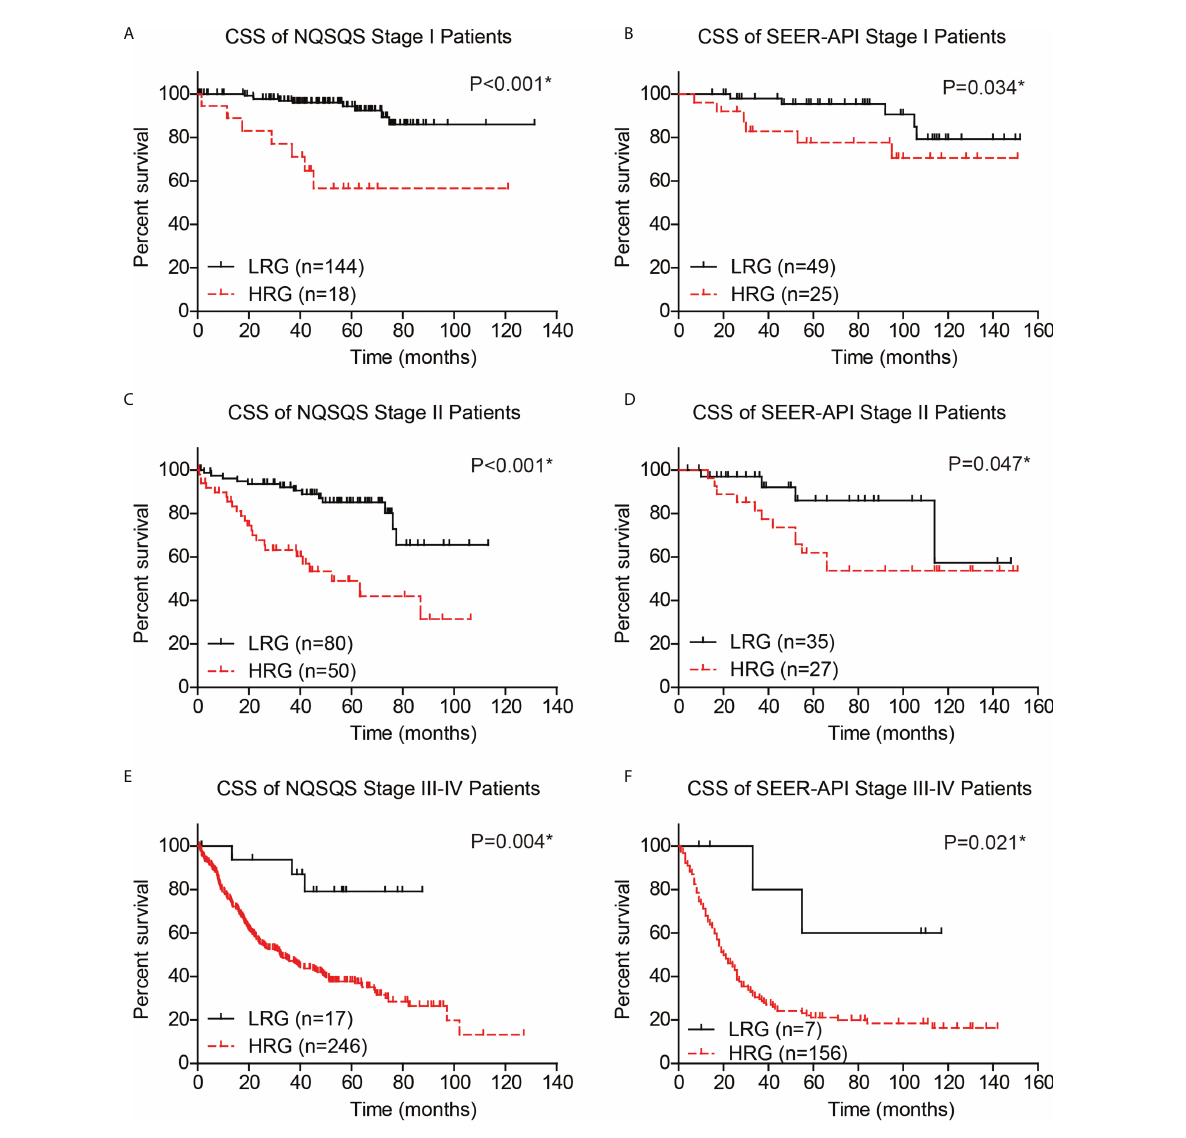
FIGURE 7 Strati fi cation survival analyses of EOGC patients based on the risk model. The cancer-speci fi c survival curves were plotted in the stage I NQSQS patients (A) , stage I SEER-API patients (B) , stage II NQSQS patients (C) , stage II SEER-API patients (D) , stage III-IV NQSQS patients (E) , and stage III-IV SEER-API patients (F) , respectively. *indicates P<0.05 by log-rank